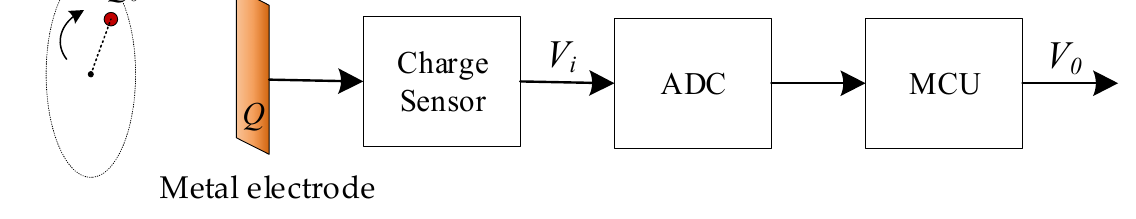
Figure 2. The process of rotor detection.